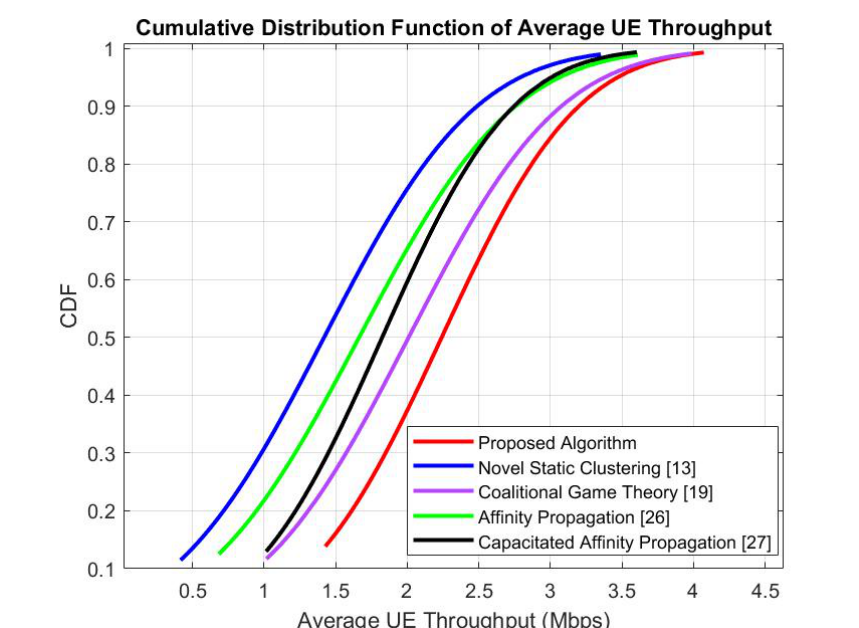
Figure 5. Cumulative distribution function of the average UE